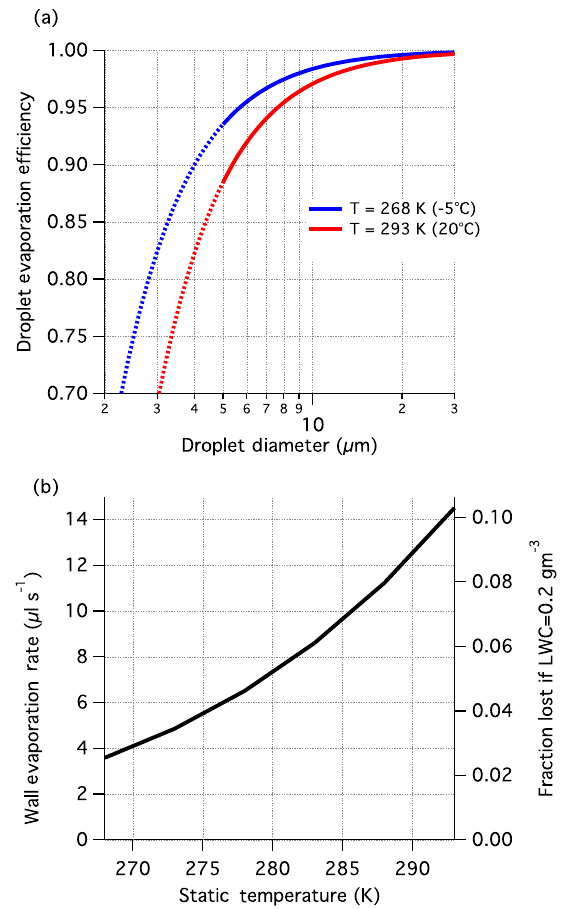
Figure 7. Evaporation losses from (a) droplets migrating to the wall ( η evap ), and (b) water on the walls ( δ evap ). Loss calculations cor- respond to nominal flight conditions for the C-130 (or equivalent) aircraft with true airspeed 115ms − 1 and a static pressure 850hPa. Interpolation is acceptable for static temperature lying within the bounds shown in panel (a) , and changes in static pressure (within 500–1000hPa) can be assumed to have negligible impact on evapo- ration. The transition from solid to dotted curves reflects the lower bound for activated droplets for purposes of the design. In panel (b) , the right axis is shown as an illustration of the effect of wall evapo- ration in the context of TCE (see text for